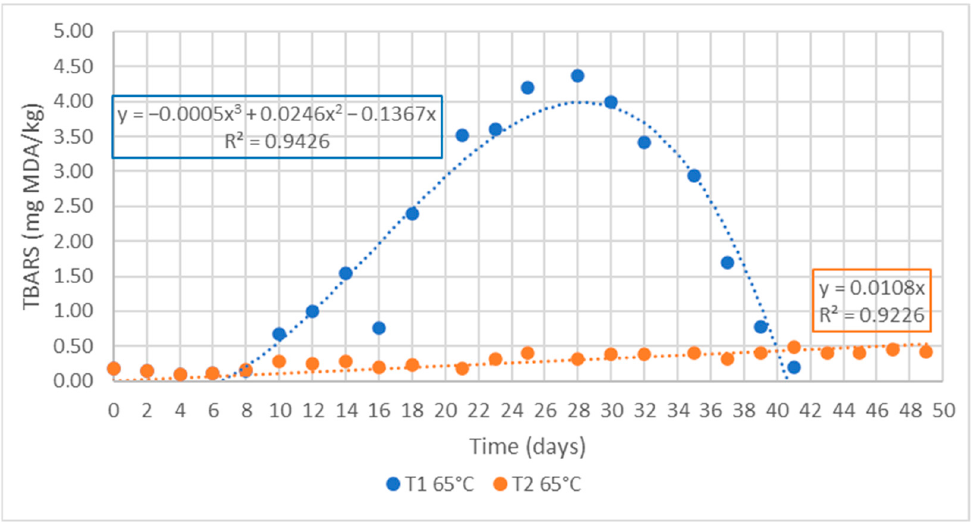
Figure 5. TBARS values obtained at T1 (control MDDM) and T2 (MDDM + 0.2% Nutrabiol ® ) during the accelerated shelf-life assay as a function of time at 65 °C.